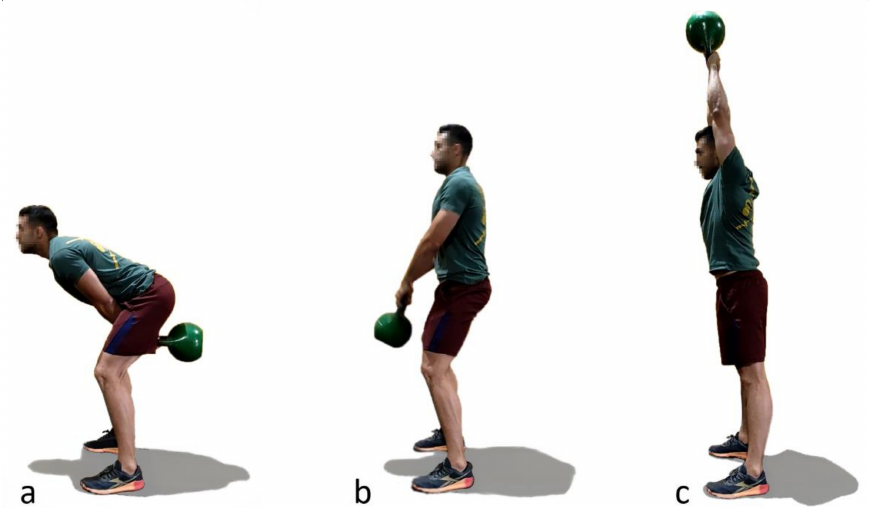
Figure 2. American kettlebell swing technique. ( a ): Step 1; ( b ): Step 2; ( c ) Step